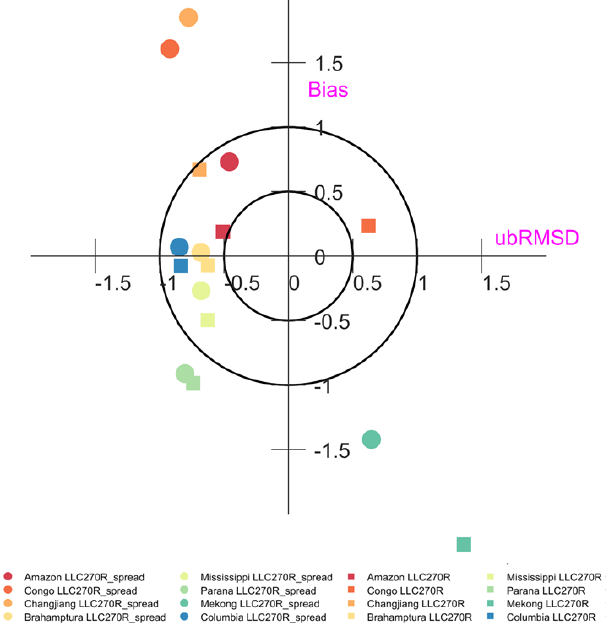
Figure 4. SSS target diagram near the selected river mouths (see Fig. S3) for LLC270R_spread and LLC270R simulations.